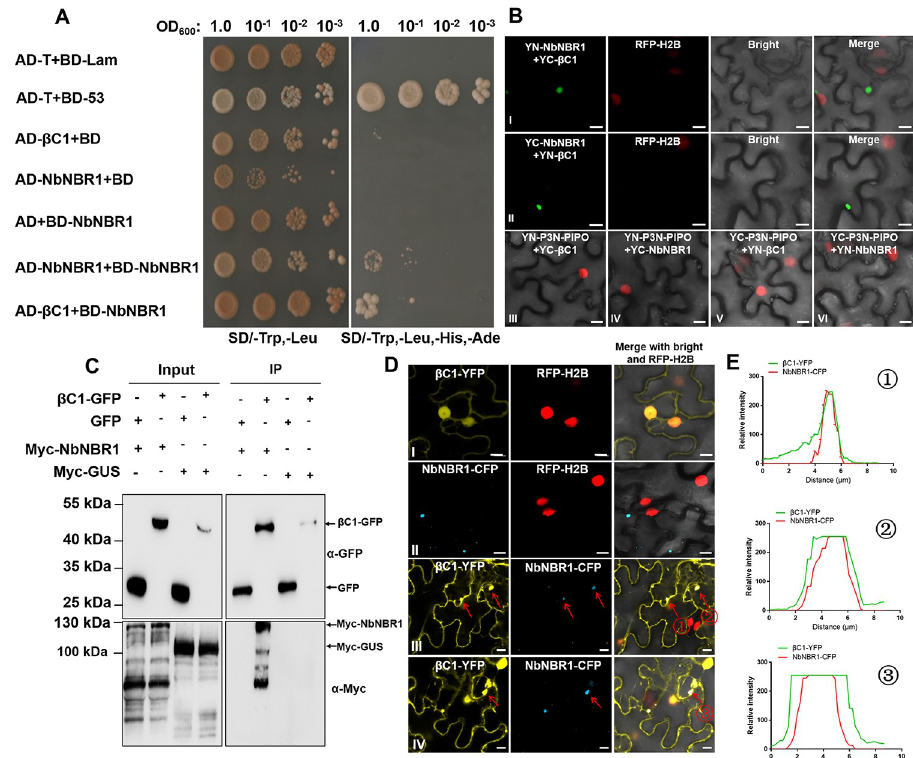
Fig 1. Determination of direct interaction between NbNBR1 and β C1. (A) Yeast two-hybrid (Y2H) assay was performed to determine the interaction between NbNBR1 and β C1. Y2H Gold yeast cells co-expressing AD-T+BD-53 or AD-T+BD-Lam were used as the positive and the negative controls, respectively. BD, binding domain of GAL4; AD, activation domain of GAL4. (B) BiFC assay was performed in the RFP-H2B transgenic N . benthamiana leaves. At 48 hpi, yellow fluorescence (green) was examined in the cells co-expressing the plasmids as indicated above. Bar = 10 μ m. (C) Co-IP assay was performed to determine protein-protein interactions. β C1-GFP, GFP, Myc-NBR1, and Myc-GUS were co-expressed, as indicated, in N . benthamiana leaves through agroinfiltration. Blots with input samples (Input) or IP samples (IP) were probed with anti-GFP or anti-Myc antibodies. Arrows indicate the expected protein bands. (D) Subcellular localization patterns of NbNBR1-CFP and β C1-YFP in RFP-H2B transgenic N . benthamiana leaf cells. (I) means the expression of β C1-YFP alone in plant cell. (II) means the expression of NbNBR1-CFP alone in plant cell. (III-IV) means co-expression of β C1-YFP and NbNBR1-CFP in plant cell. YFP, RFP, and CFP fluorescence were captured under a confocal microscope. Arrows show the granules from overlapping of NbNBR1-CFP and β C1-YFP. Bar = 10 μ m. The integrity of fused proteins in Fig 1D was confirmed by Western blot (S1B Fig). (E) Fluorescence intensity of cytoplasmic granules at Fig 1D (III and IV) was quantified by ZEN 3.1 (Carl Zeiss ZEN system). The overlapping fluorescence spectra of β C1-YFP and NbNBR1-CFP from the red arrow marked region of Fig 1D (III and IV) showed their co-localization.